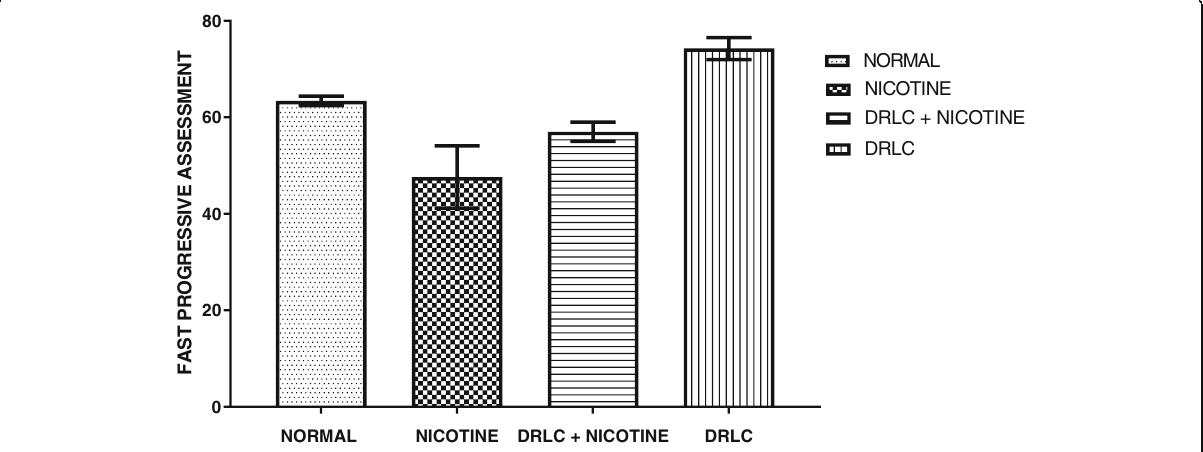
Fig. 12 Chart showing the fast-progressive assessment of the experimental animals. Values are mean ± SEM. N = 5